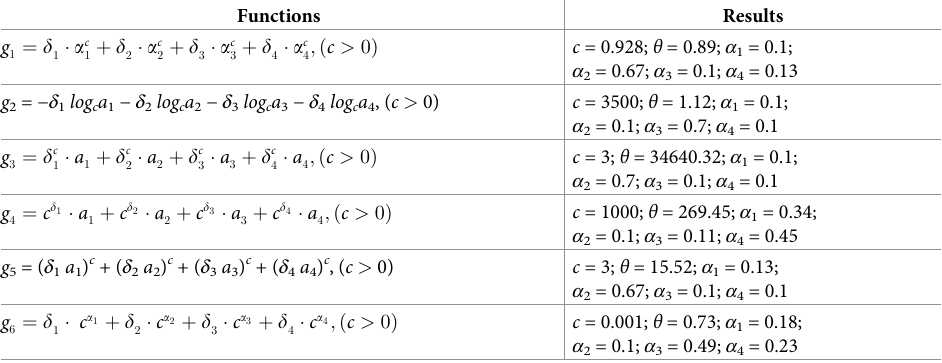
Table 5. The six sets of functions for the least square method and their relevant optimization results. Functions